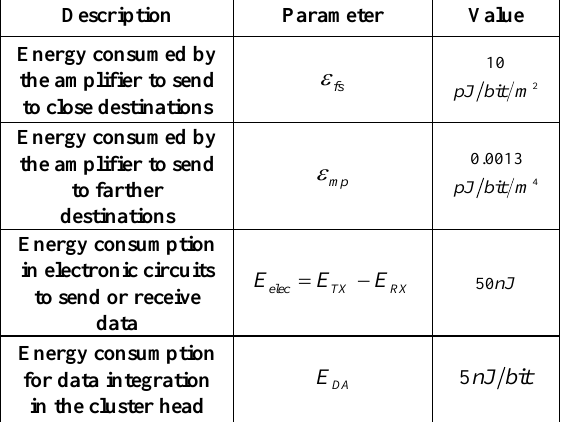
Table 1. Energy Consumption Parameters in the Simulation